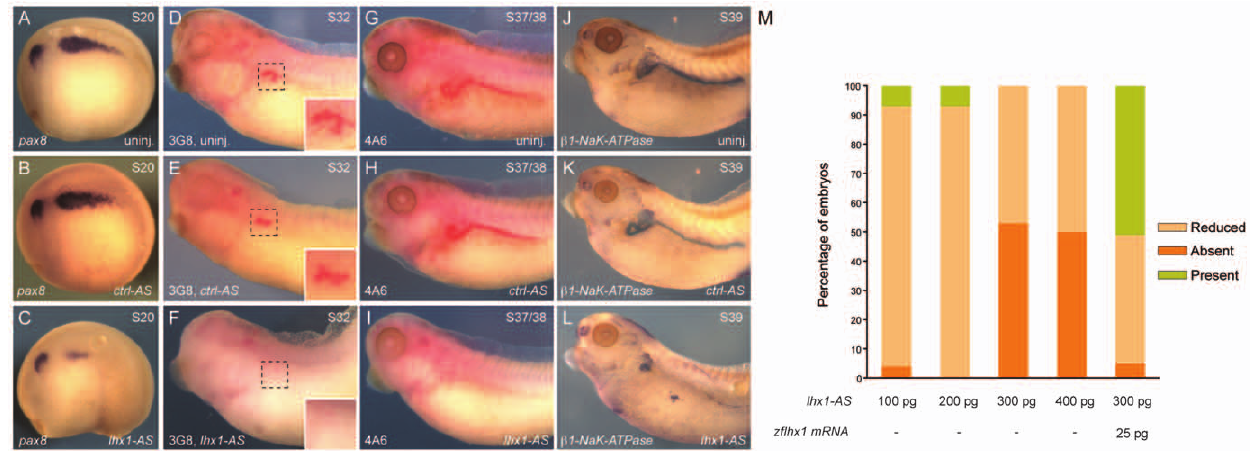
Figure 4. Depletion of lhx1 results in a loss of the pronephric kidney. Embryos were injected (1xV2) with 300 pg of ctrl-AS or lhx1-AS at the 8- cell stage. ( A, D, G, J ) Uninjected embryos. ( B, E, H, K ) Embryos injected with ctrl-AS . ( C, F, I, L ) Embryos injected with lhx1-AS . ( A–C ) In situ hybridization of embryos at stage 20 for the pronephric marker pax8 . ( C ) Reduced or absent pax8 expression was observed in 47% and 53% of the embryos, respectively (n=34). ( D–F ) 3G8 whole-mount immunostaining was carried out at stage 32. ( E ) Reduced 3G8 staining was observed in 5% of the embryos (n=41). ( F ) Reduced 3G8 staining was observed in 76% of the embryos (n=34). Insets show enlargement of 3G8 staining of the proximal tubule. ( G–I ) 4A6 whole-mount immunostaining was carried out at stage 37/38. ( H ) Reduced 4A6 staining was observed in 9% of the embryos (n=23). ( I ) Reduced 4A6 staining was observed in 91% of the embryos (n=34). ( J–L ) In situ hybridization of embryos at stage 39 for b 1-NaK- ATPase . ( L ) Reduced b 1-NaK-ATPase expression was observed in 72% of the embryos (n=29). ( M ) Bar graph with the percentage embryos injected with the different doses of lhx1-AS that showed presence, reduction or absence of pax8 expression at stage 20. Lhx1-AS 100 pg: reduced pax8 expression was observed in 89%, absence in 4% and presence in 7% of the embryos (n=28). Lhx1-AS 200 pg: reduced pax8 expression was observed in 93% and presence in 7% of the embryos (n=27). Lhx1-AS 300 pg: reduced of pax8 expression was observed in 47% and absent in 53% of the embryos (n=34). Lhx1-AS 400 pg: reduced pax8 expression was observed in 50% and absent in 50% of the embryos (n=42). Lhx1-AS 300 pg + zflhx1 mRNA 25 pg: presence of pax8 expression was observed in 51% of the embryos (n=41).